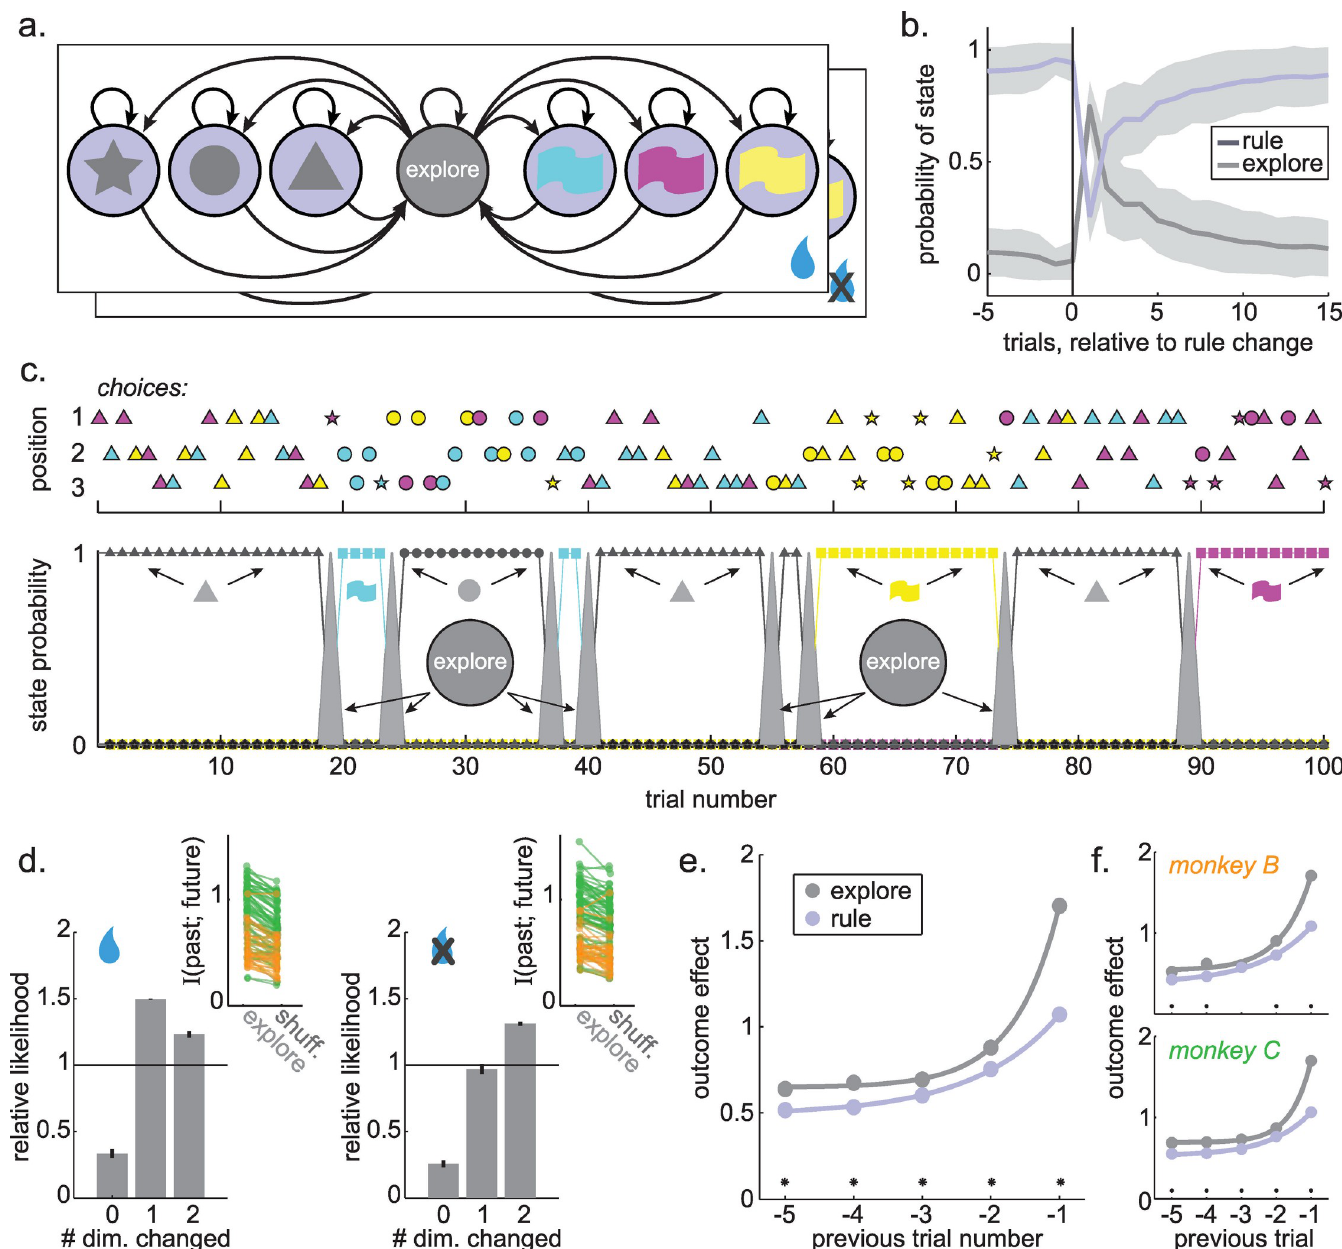
Fig 4. Hidden Markov model (HMM) design and fit to behavior. A) The structure of the HMM, with one latent state for each possible rule, plus one latent “explore state”. Emissions (not shown) match the rule in the rule states, and are randomly allocated during the explore state. The box around the model indicates that this model has multiple “plates”, which depend on the reward of the previous trial (bottom right). Each path (p(transition) between states) depends on whether reward was or was not delivered on the previous trial. B) The posterior probability of explore states and any of the rule states (1-p(explore)) is illustrated as a function of trials relative to change points in the rewarded rule. Shading: +/- STD. C) Example choice sequence and state labels. Top) A sequence of 300 chosen options, separated vertically by whether the chosen option was in location 1, 2, or 3. Bottom) The state probabilities from a fitted HMM. Colored boxes correspond to the color-rule states (blue, yellow, and magenta). Black shapes correspond to shape-rule states (triangle, circle, square). The filled gray line corresponds to the explore state probability. D) Choices made during exploration were organized with respect to choice history. Right) The likelihood that exploratory choices after reward delivery will differ from the previous choice in 0, 1, or 2 stimulus dimensions, normalized by expected frequency of that choice type. Inset) Mutual information for real explore choices compared to explore choices with shuffled choice history for all sessions in monkey B (orange) and monkey C (green). Left) Same as right, for trials following reward omission. E) The outcome effect index for outcomes received during exploration (gray) or during rules (purple), illustrating the effects on 1 to 5 choices into the future. F) Same as E, plotted separately for monkey B (top) and monkey C (bottom).